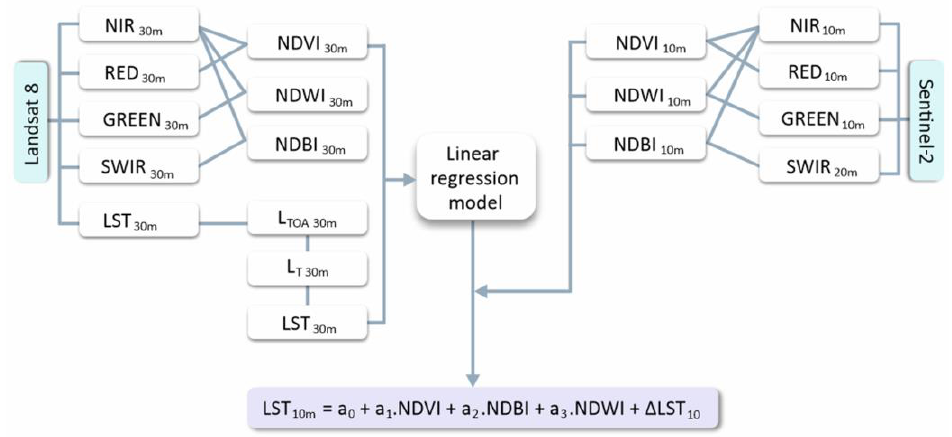
Figure 2. Workflow for downscaling the Landsat 8 LST with Sentinel-2 spectral indices and linear regression model.